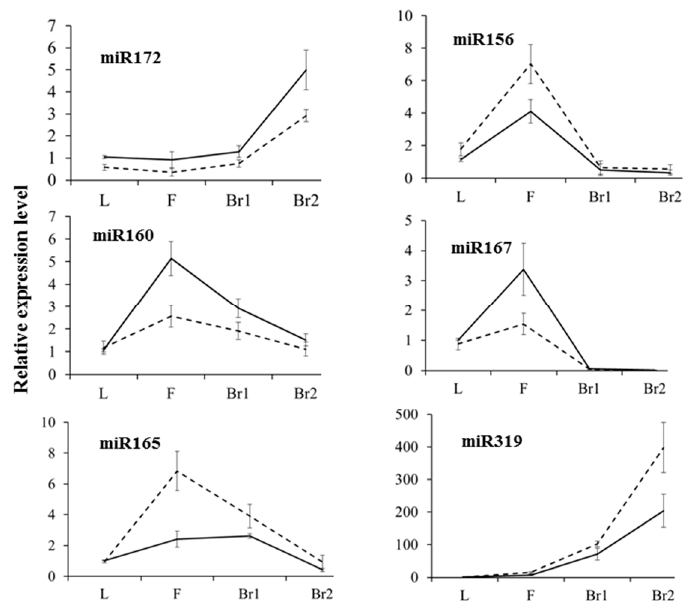
Figure 9. Validation of selected differentially expressed miRNAs by qRT-PCR in the leaf (L), flower bud (F), branching site at bolting (Br1), and branching site at early flowering (Br2) in 6098B (solid line) and Purler (dotted line), performed on the same tissue samples used for verifying gene expression. Data represent means (three biological replicates) ± standard deviation.